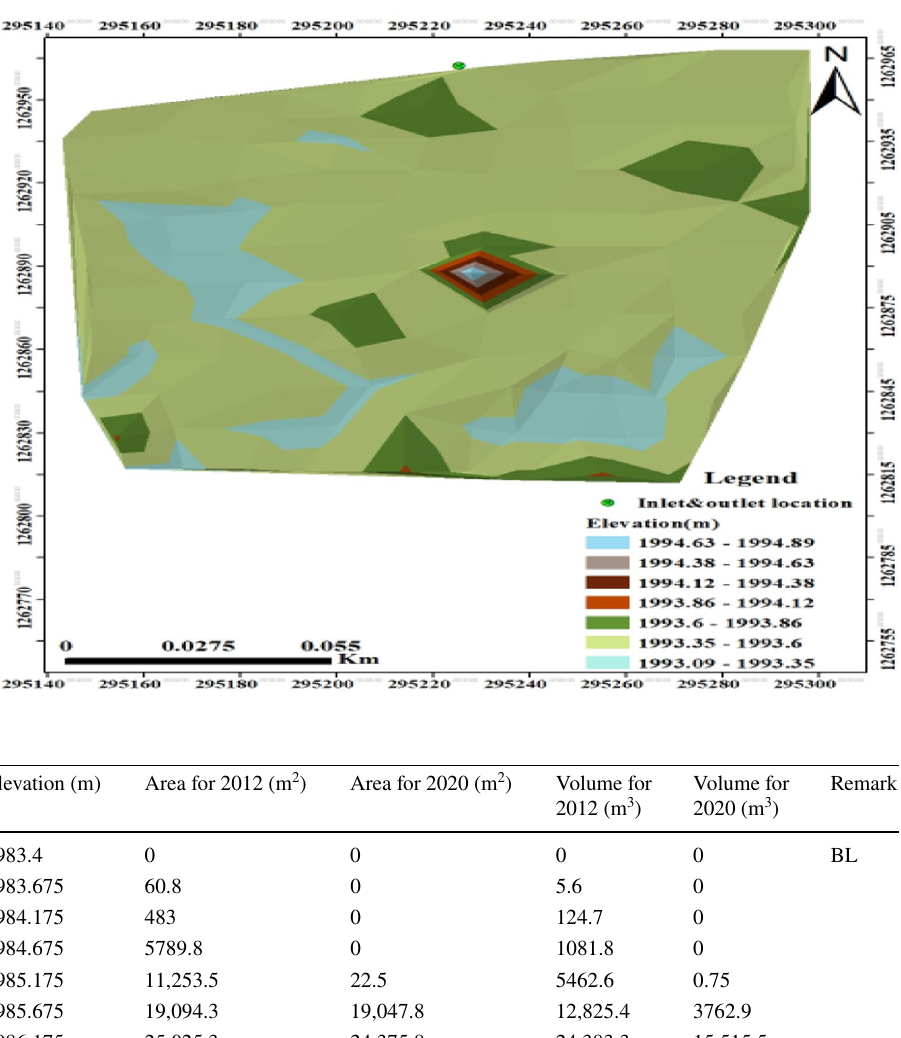
Fig. 10 Adebra NSR TIN map derived from bathymetry survey